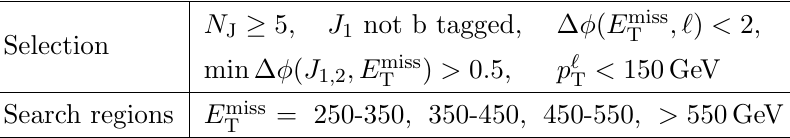
; ‘ ) denotes the angle between ~p miss and the ~p T of the lepton, T T